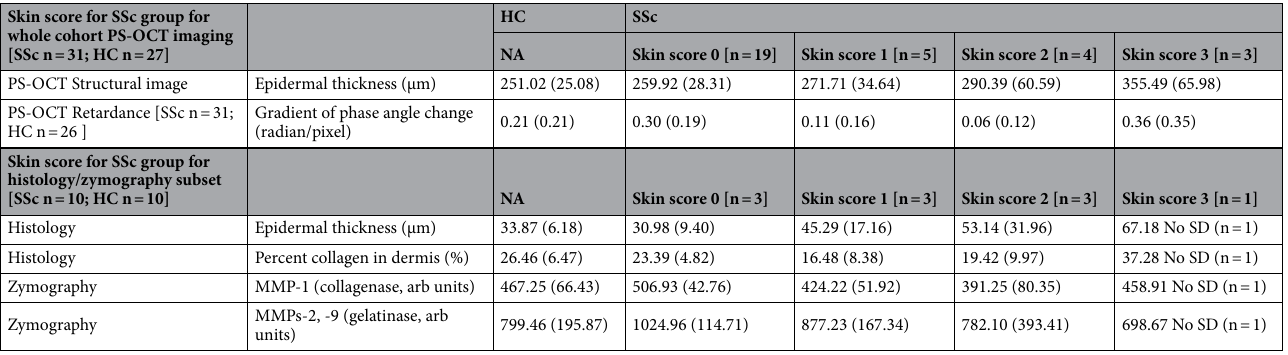
Table 2. Mean (SD) values of PS-OCT and